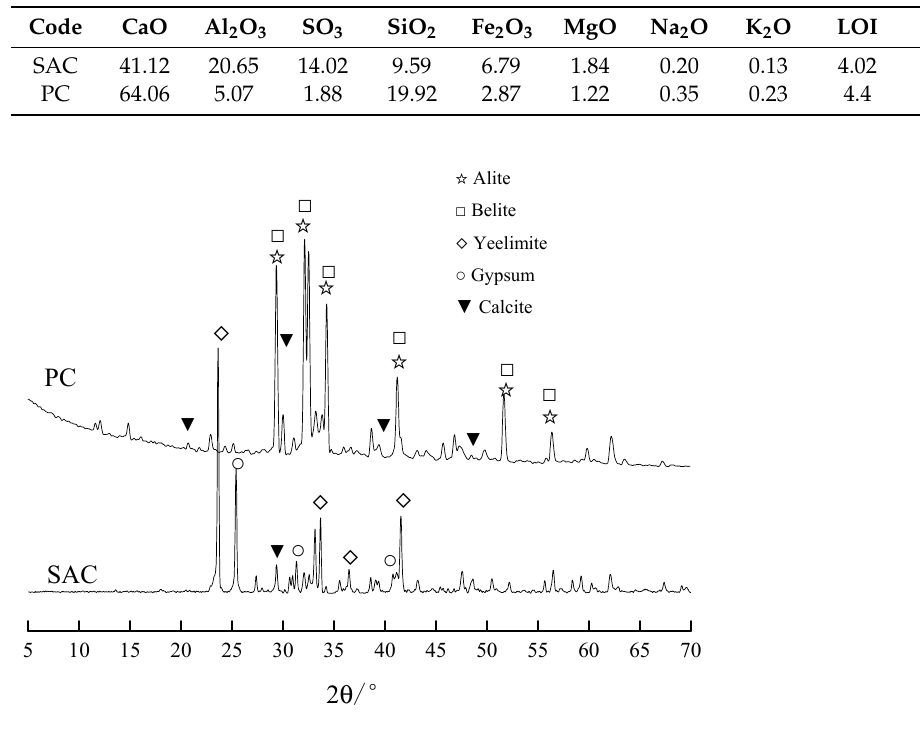
Table 1. Chemical composition of SAC and PC.